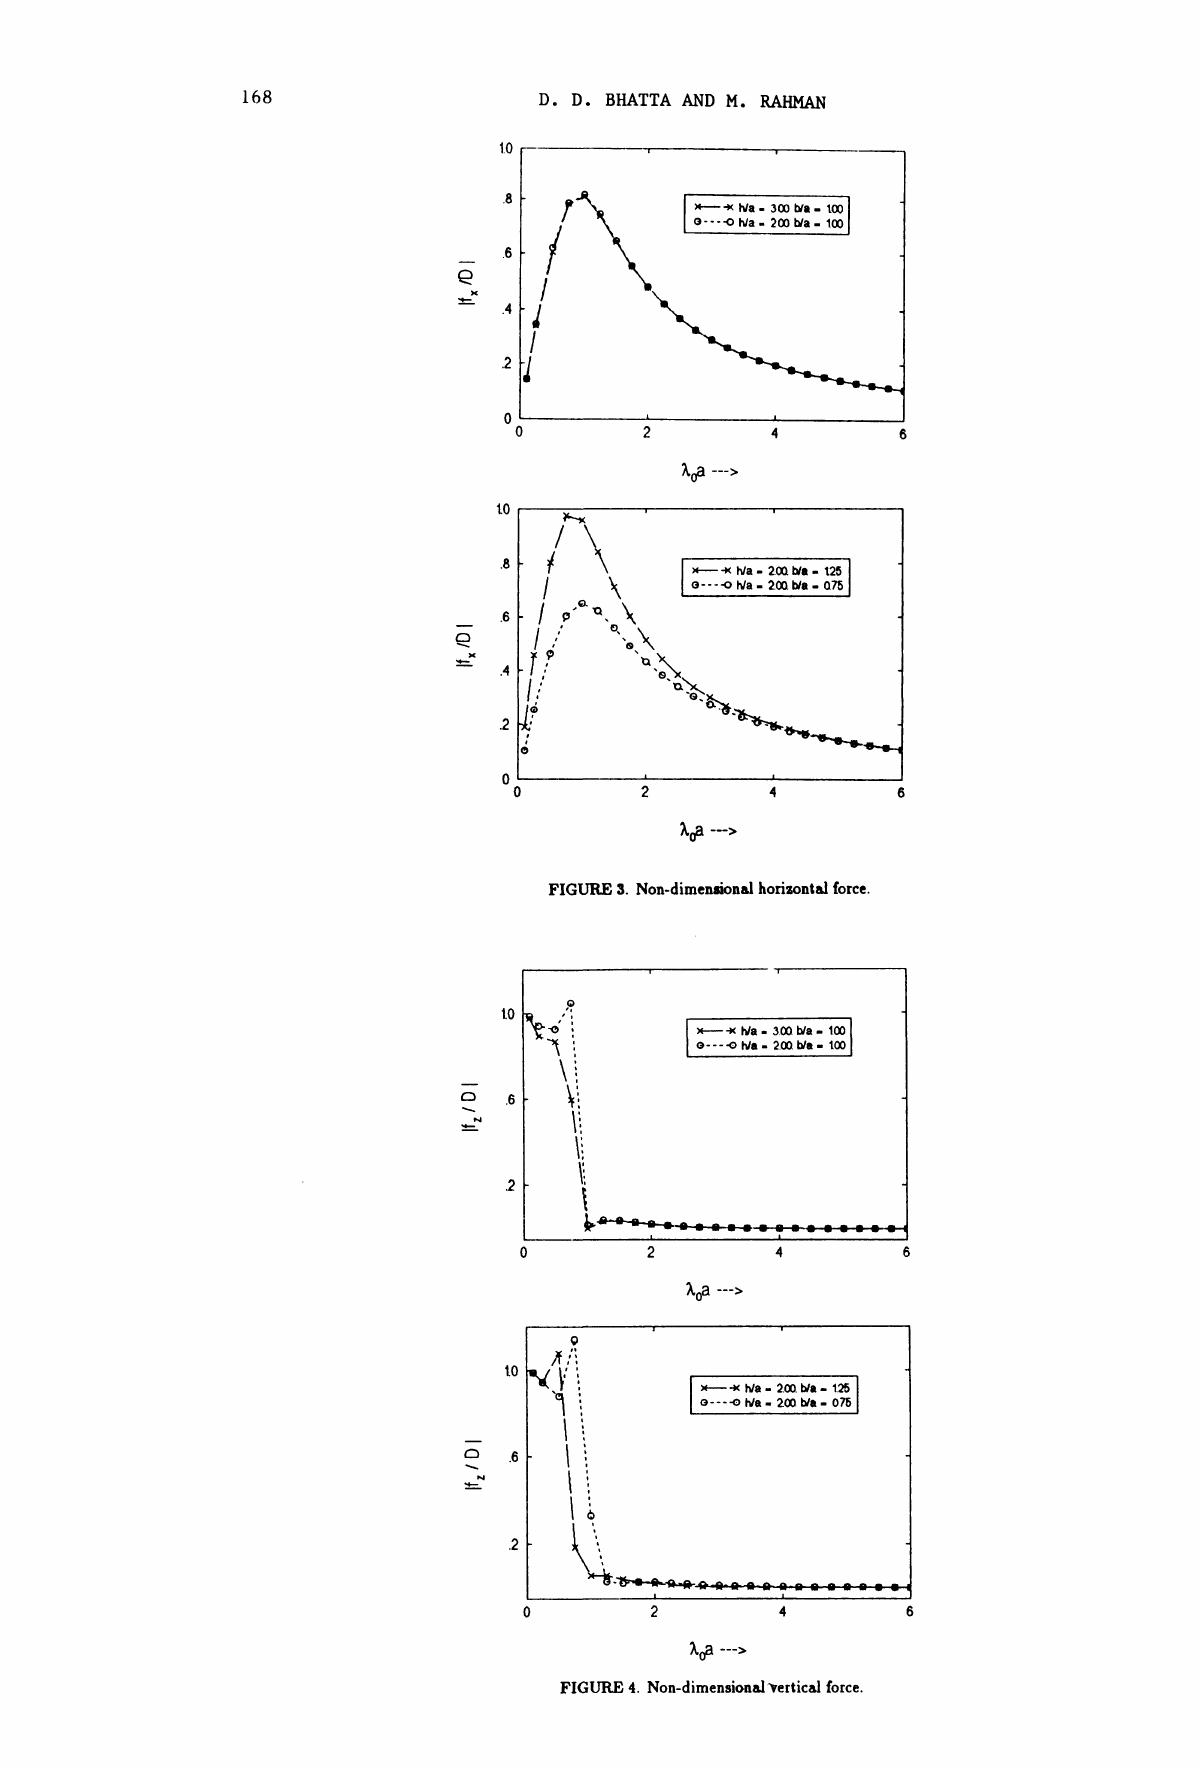
FIG 4. Non-dimensiMertical